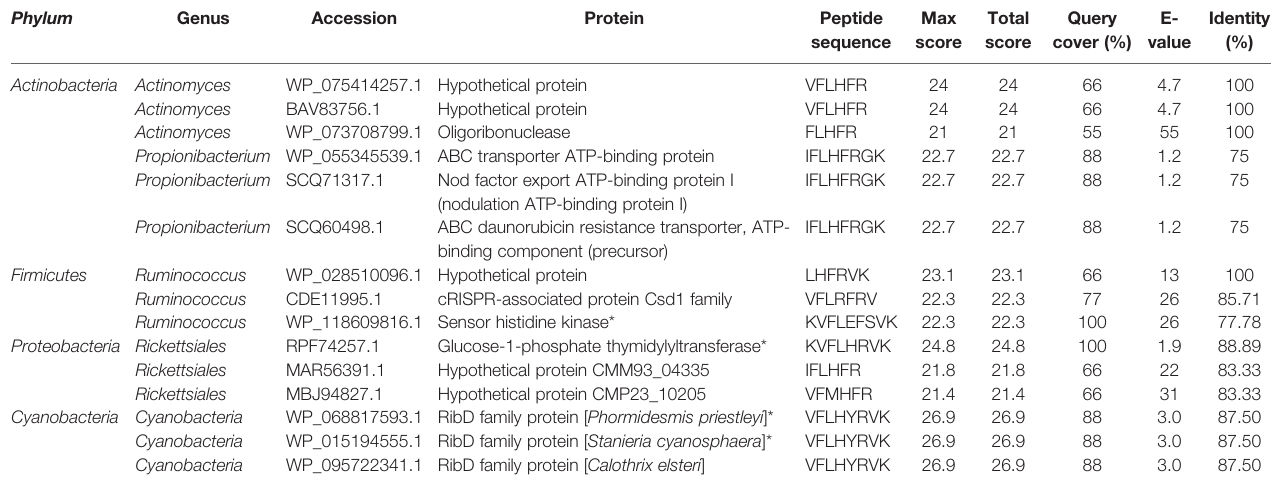
TABLE 2 | Sequence similarity analysis between the putative antigen sequence (K 1 V 2 F 3 L 4 H 5 F 6 R 7 V 8 K 9 ) and EAT microbiota genome as performed by BLASTp (25).